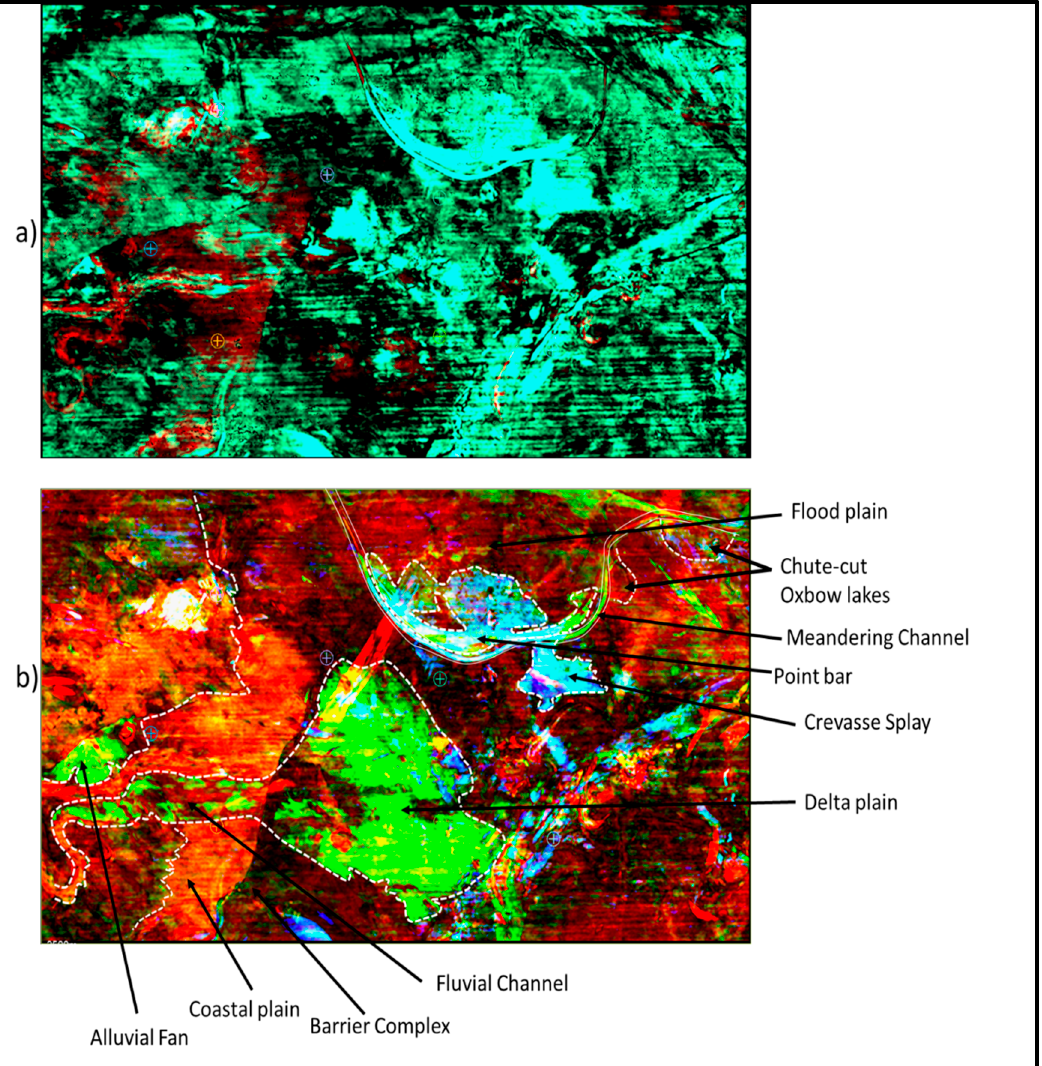
Figure 21. ( a ) generalized spectral decomposition of the data before bandwidth extrapolation (time slice—300 ms), ( b ) generalized spectral decomposition of the data after bandwidth extrapolation (time slice—300 ms). GSD volumes of 10, 30, and 40 Hz frequencies were blended using the RGB tool. The symbols ⊕ indicate the well locations.